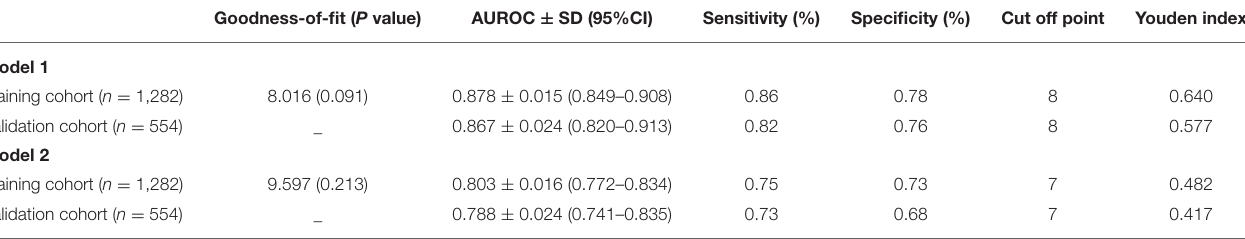
TABLE 4 | Predictive performance of prediction model system for ischemic AKI within 30-day and 1-year all-cause death in the training cohort and validation cohort.